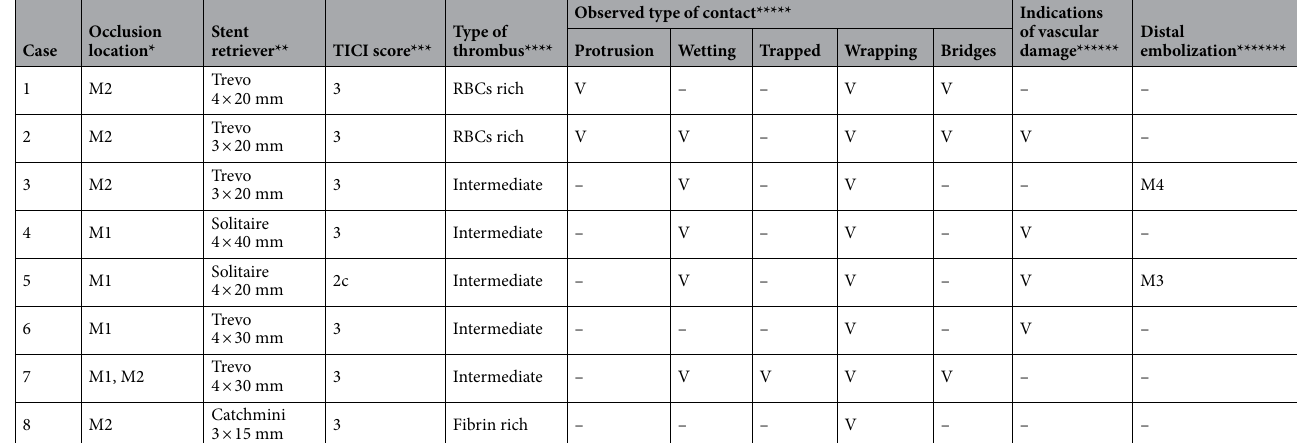
Table 1. Characteristics of retrieved thrombi. *Thrombi were situated within segments of middle cerebral artery (MCA), for all the investigated cases, and retrieved with one pass MTB. **TREVO Striker, Kalamazoo, Michigan, USA; Solitaire Medtronic, Minneapolis, USA; Catch-Mini, Balt, Montmorency, France. ***According to Thrombolysis in Cerebral Infarction (TICI) scale, used for grading the result of